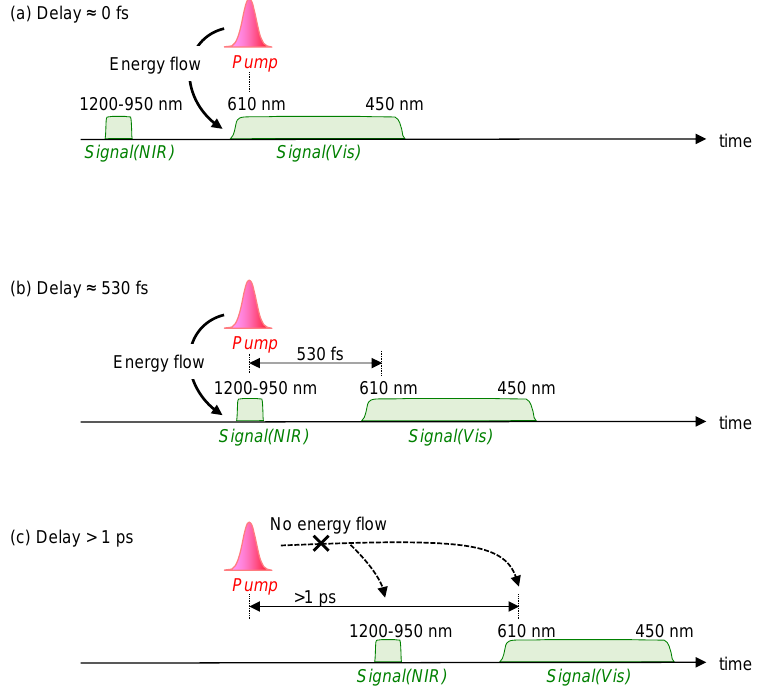
Figure 6. The schematic drawings of the temporal relations between the pump pulse and the signal spectral components at delays around ( a ) 0 fs, ( b ) 530 fs, and ( c ) longer than 1 ps. The input signal contained the near-infrared (NIR) spectral components as discussed in the text.